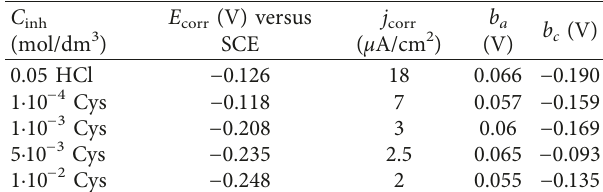
Table 1: Corrosion parameters for brass in 0.05M HCl solution with addition of various concentrations of cysteine.